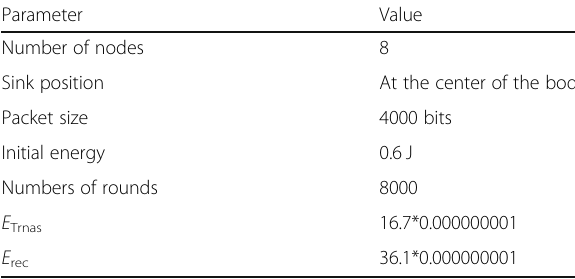
Table 2 Simulation parameters for the proposed WBAN